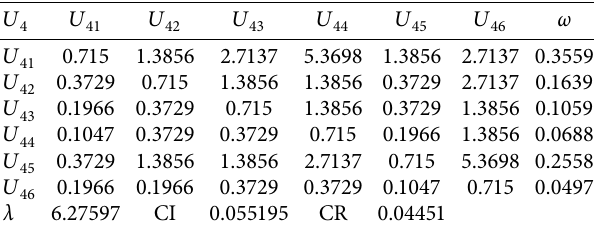
Table 8: Indicator judgement matrix and the weights of the op- erational risk.